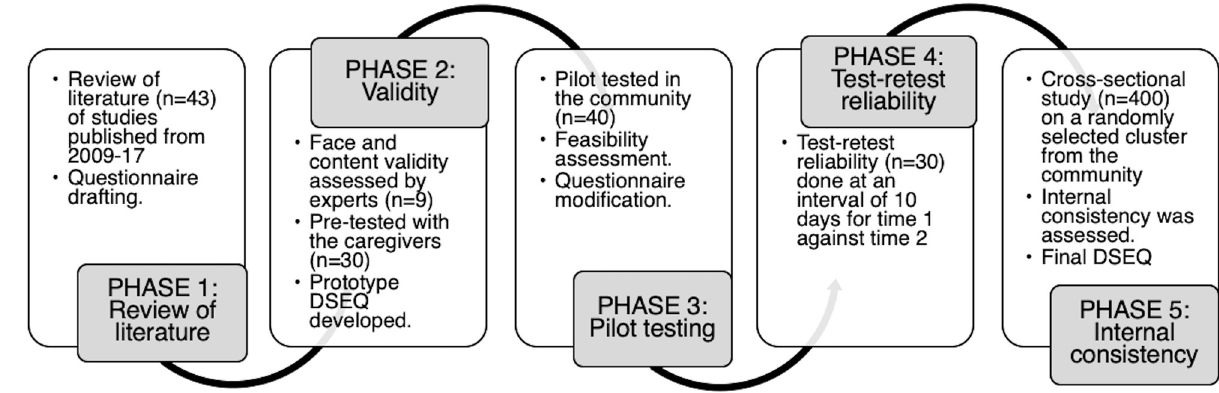
Fig 1. Phases of designing the digital-screen exposure questionnaire